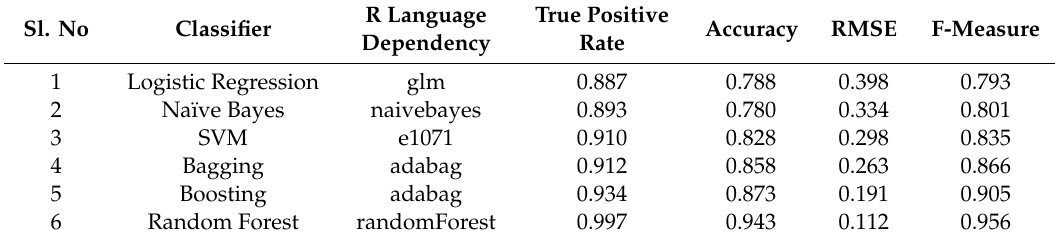
Table 6. Performance of models in re-development phase after privacy